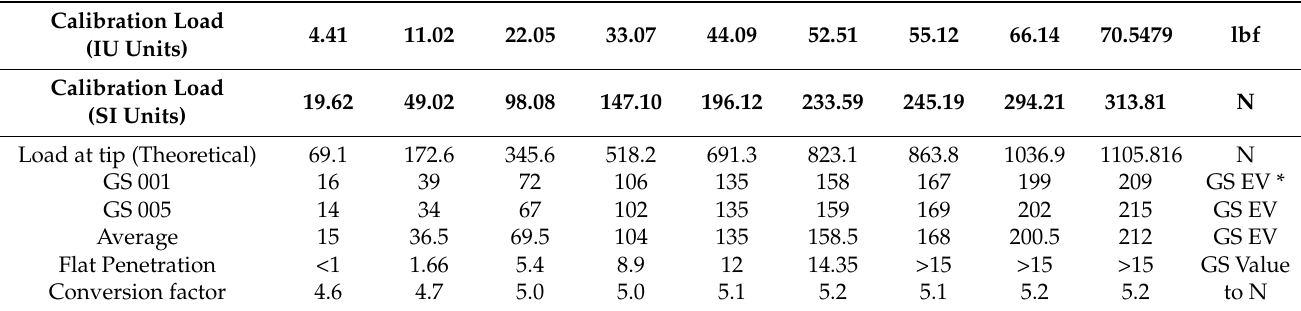
Table A8. The table shows the results from varying force applied to the Going Stick’s probe tip using the calibration rig, in engineering mode.